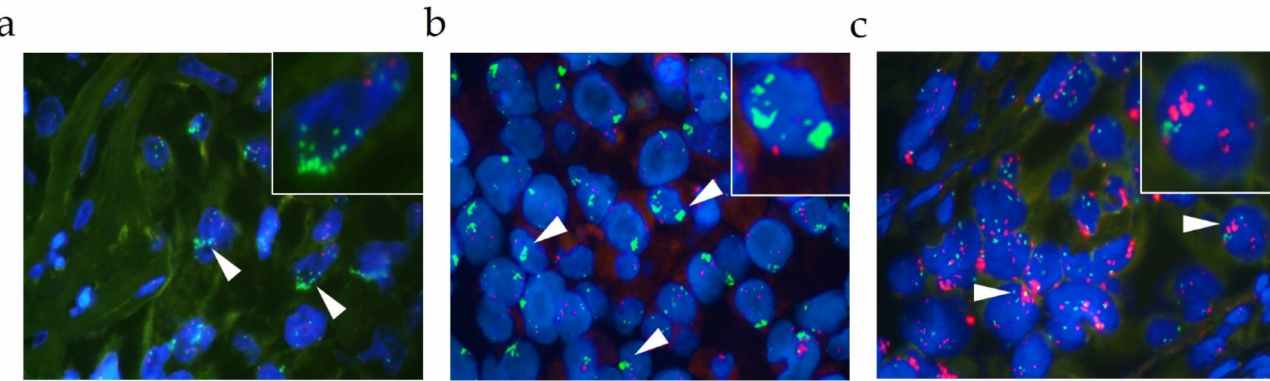
Figure 1. Overview of the various facets of a MET amplification assessed by FISH (each 1000 × magnification). Representa- tive fluorescence images showing a high-level MET gene amplification characterized by ( a ) a high MET GCN, ( b ) cluster- formation ( c ) or accompanied polysomy. Green signals represent the MET probe, red signals represent the CEN7 probe. White arrows indicate the relevant areas. Images in the upper right are magnified areas of the analyzed slide.